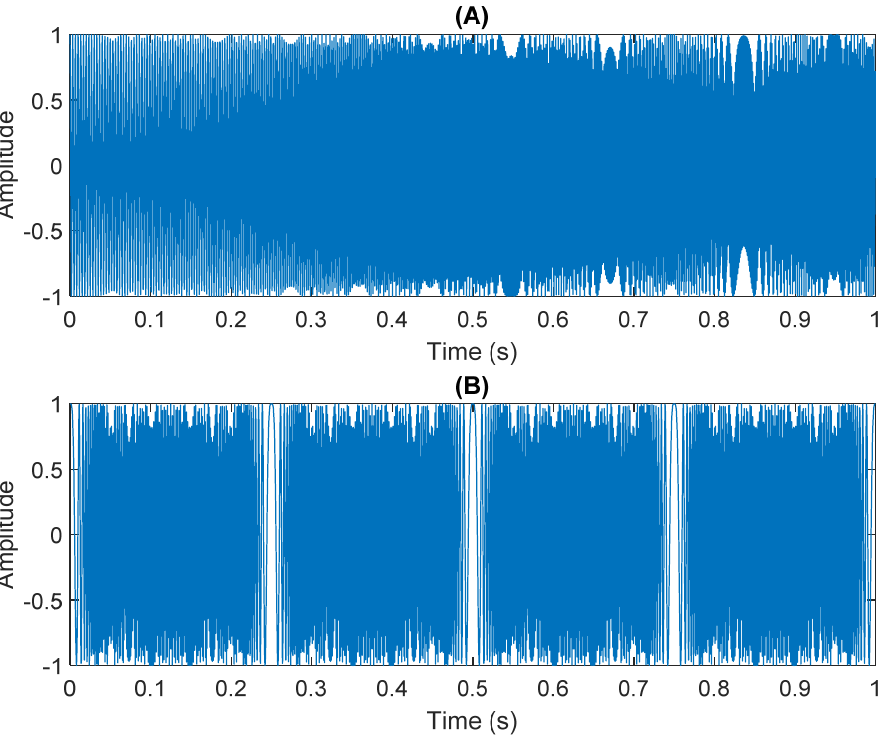
Figure 18. Original sources: ( A ) Quadratic chirp, the frequency of which increased from 300 to 1300 Hz during the measurement. ( B ) The instantaneous frequency of the compound chirp and the chirp with sinusoidally varying frequency